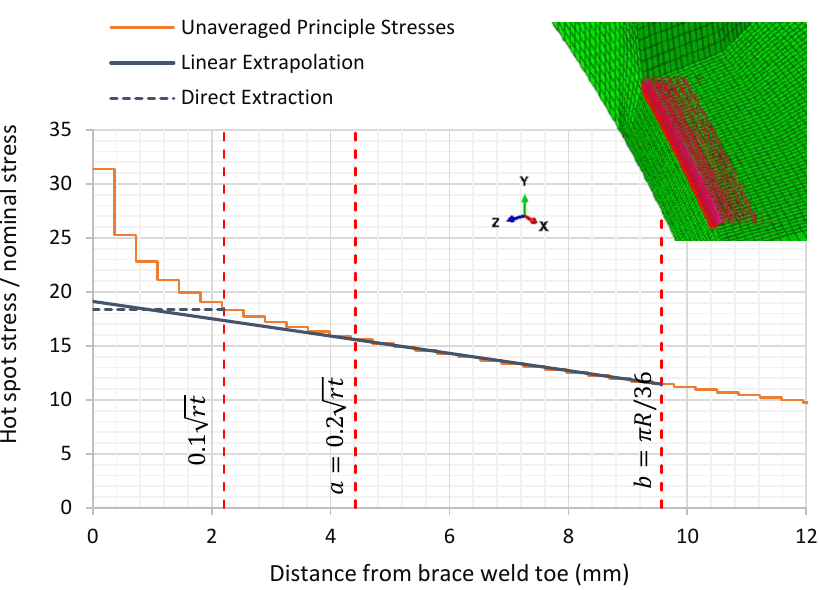
Figure 10. Experimentally measured SCFs sensitivity.